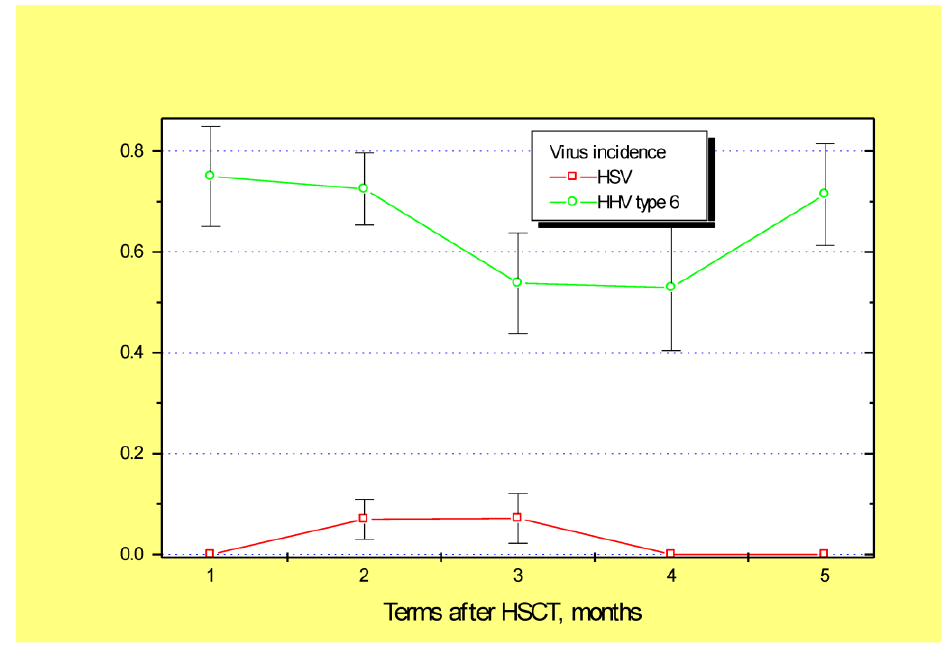
Figure 1. General incidence of HSV (red squares) and HHV-6 (green circles) in the intestinal biopsies from the first month (D + 1 to D + 30) up to 5–6 months after allogeneic HSCT. Abscissa, time period following HSCT, in months; ordinate, incidence of positive PCR viral tests (M ± m).